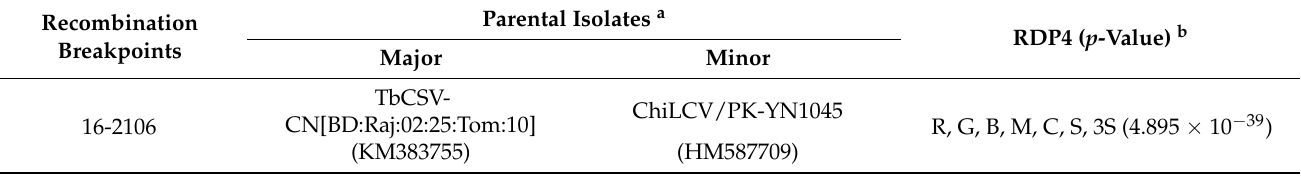
Table 4. Detection of possible recombination in the TbCSV-[Myanmar] DNA-A